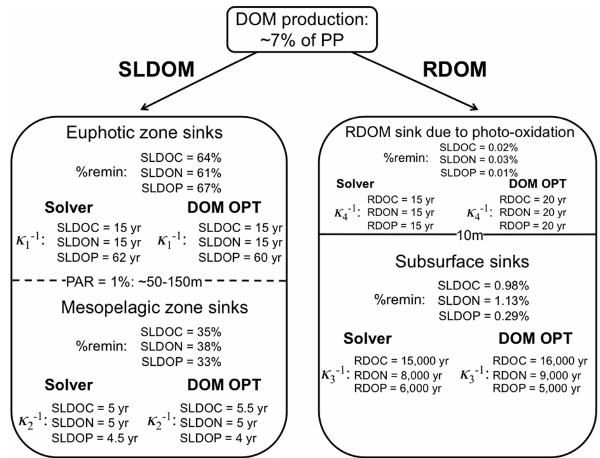
Figure 2. Configuration of the DOM remineralization scheme and parameter values from the modified DMI-enabled DOM model (solver) and the DOM OPT simulation of the CESM BEC. Note the only minor changes to tracer lifetimes, κ − 1 , between the mod- i ified DMI-DOM model and the DOM OPT simulation. The value “%remin” represents the percentage of the DOM production flux that is remineralized within each depth horizon on an annual basis and is common to both